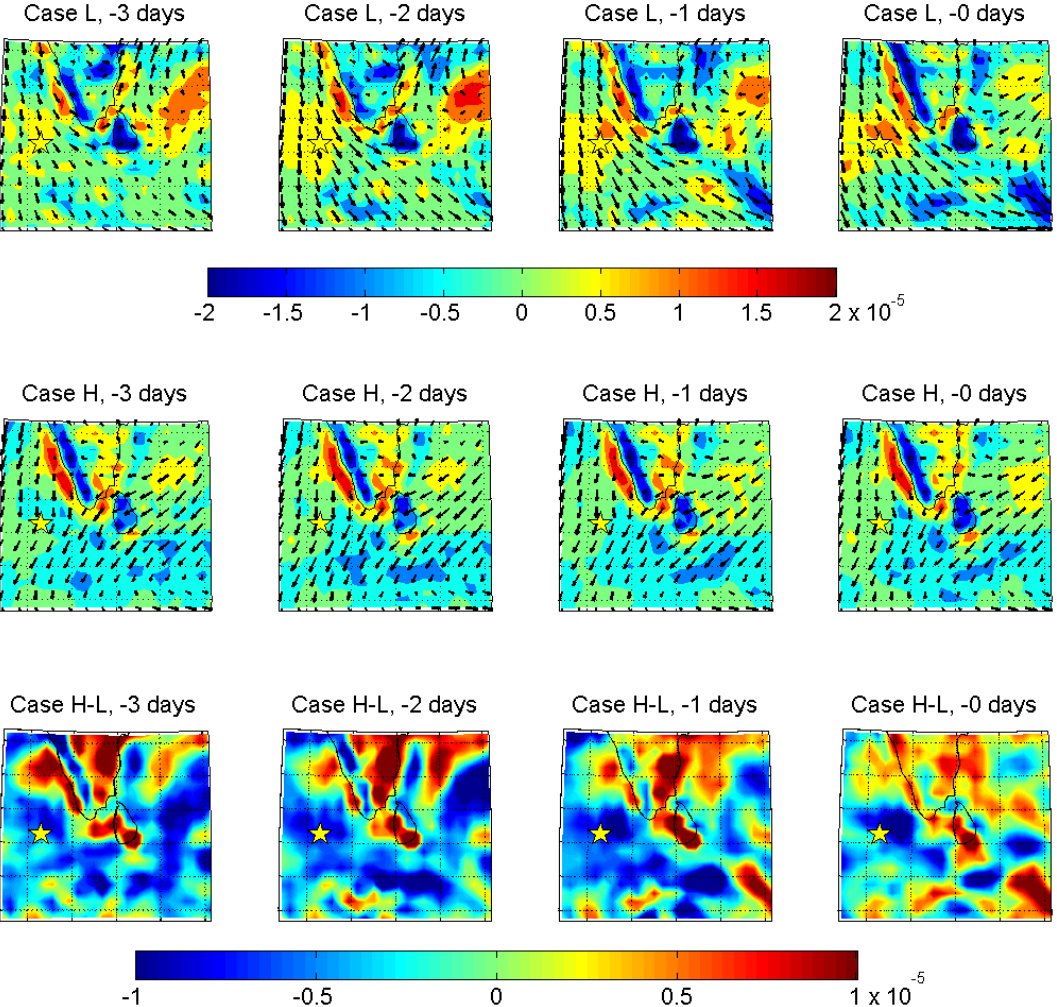
Figure A9. As in Figs. A6 through A8, showing ECMWF 1000hPa divergence (s − 1 ) overlaid with average winds for the preceding 3 days and the day in question – Case L, Case H, or the difference (H −